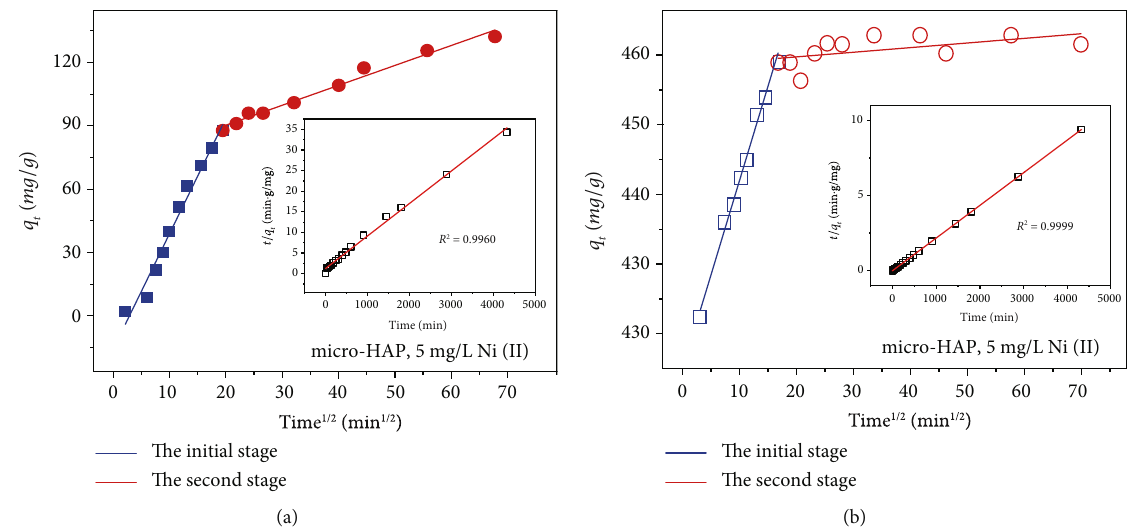
, s / l = 0 : 6 g/L, ½ Ni ð II Þ = 5 : 0 4